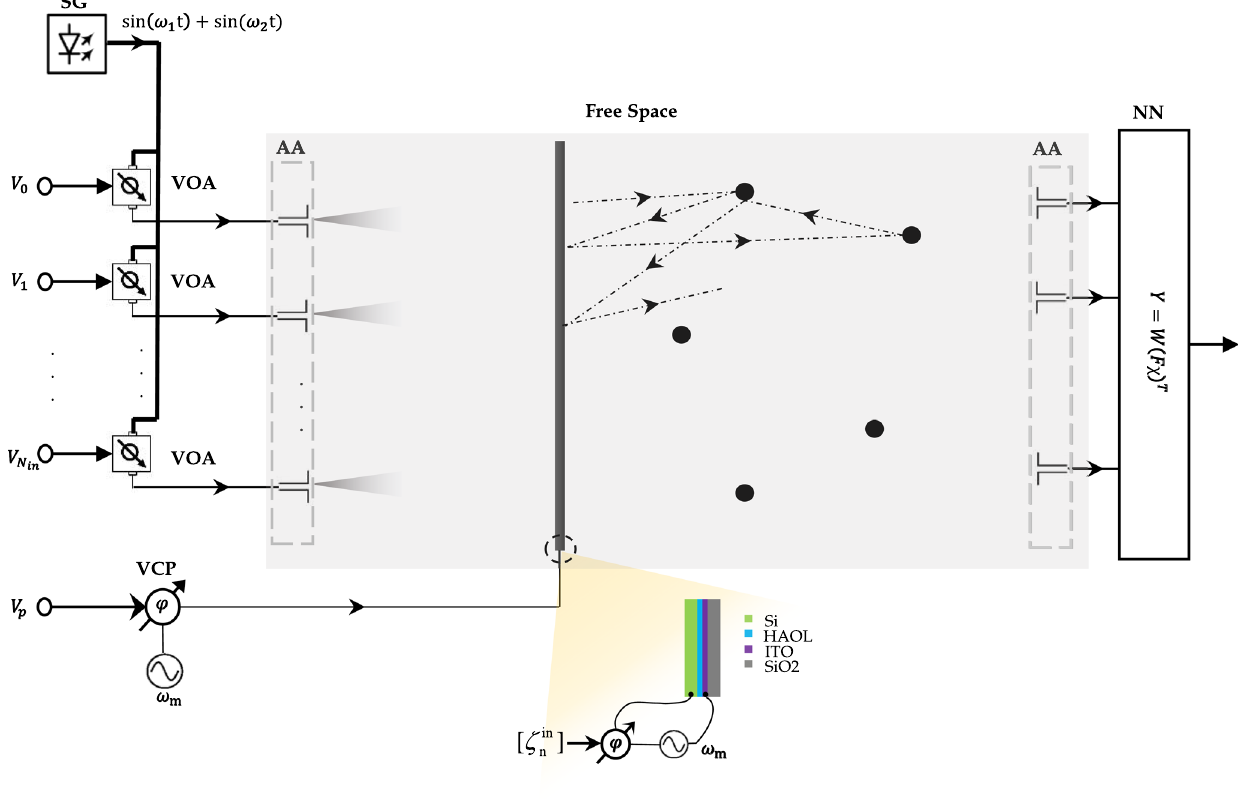
Fig. 9 A detailed schematic of the proposed wave-based ELM architecture. On the left, the input side includes a signal generator (SG) with variable attenuators (VOA) that encode the information. A Voltage-controlled phase shifter (VCP) is used to change the phase of the modulation depending on the voltage applied, which is fi xed for each input and does not change in time. AA denotes the array of source antennas. V p is the required voltage to control the VCP ( V p ¼ γ (cid:2) ζ in ), where (cid:2) ζ in and γ are the mean of input vector and a scaling factor,